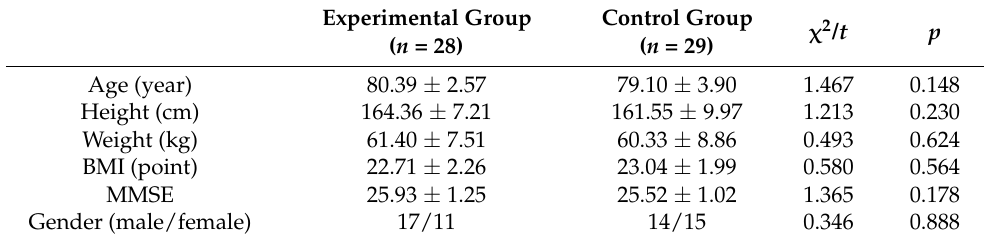
Table 1. General characteristics of the subjects.